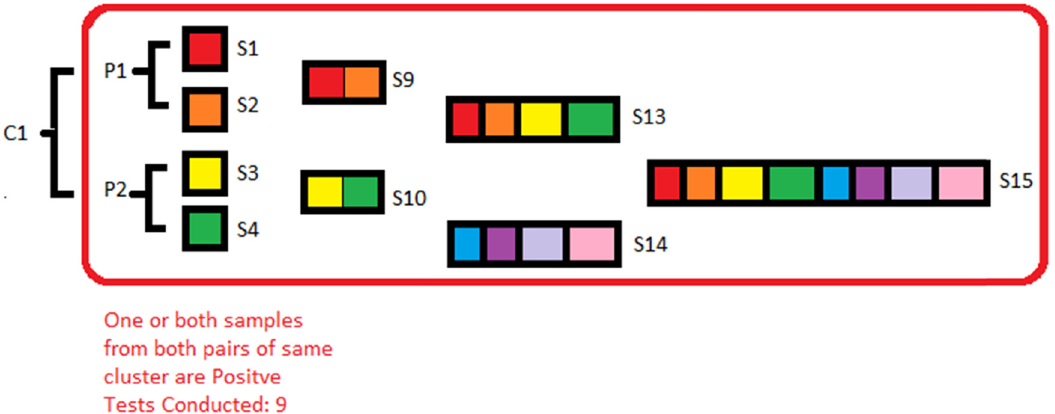
Figure 5: Nine tests to be performed for testing eight